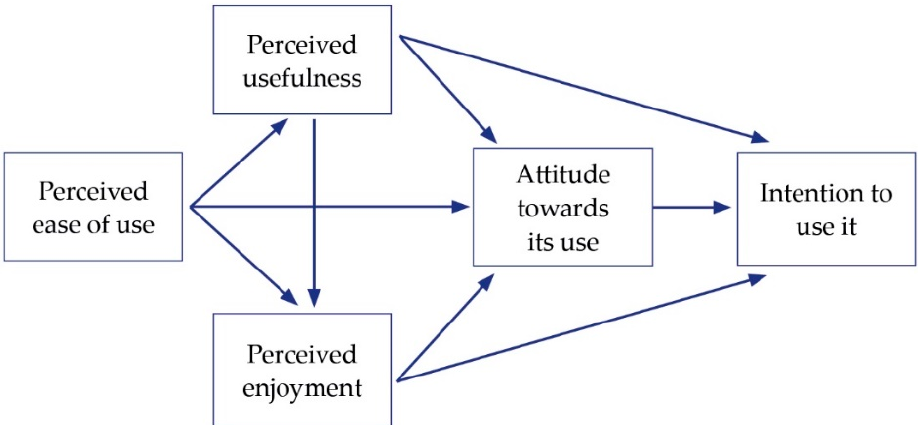
Figure 4. TAM’s graphic representation [58]. Source: developed by the authors from Davis [58].